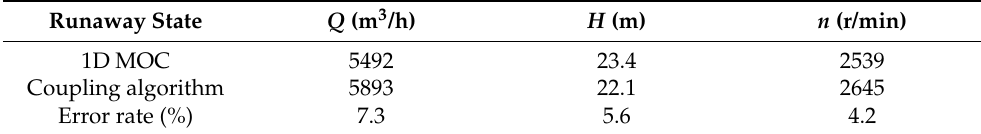
Table 3. Comparison of the main parameters of the turbine runaway